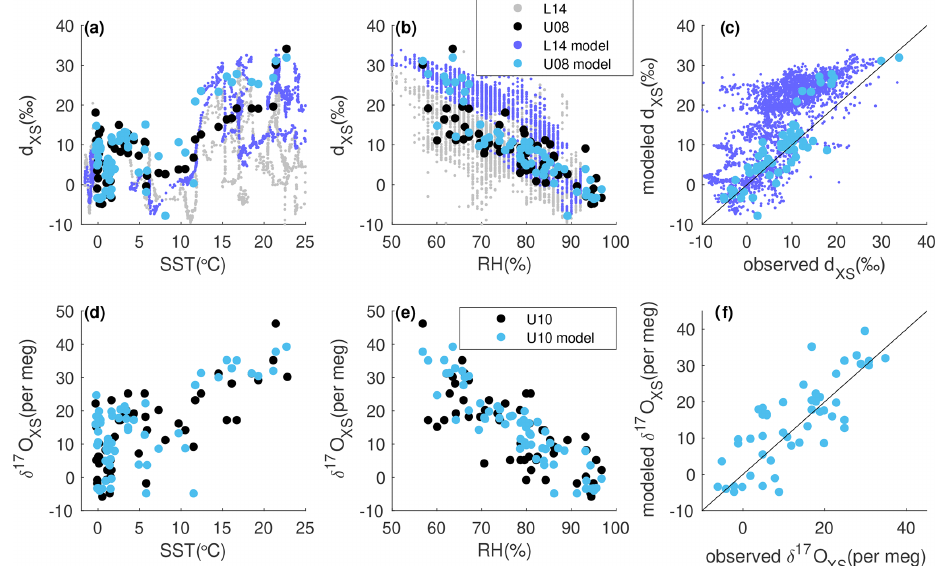
Figure A4. Comparison of modeled and observed isotope excess parameters and relationship to source region conditions. (a) Observed d xs and SST relationship in Southern Ocean vapor from Uemura et al. (2008) (black dots, U08) and Liu et al. (2014) (grey dots, L14). SWIM results for evaporation under SST and RH conditions observed coincident with vapor measurements of Uemura et al. (2008) (cyan dots, U08 model) and Liu et al. (2014) (purple dots, L14 model). (b) Same as (a) but for modeled and observed d xs -to-RH relationship from observations of Uemura et al. (2008) The Liu et al. (2014) observations and model show a similar trend and are omitted for visual clarity. (c) Observed 17 O xs and SST relationship in Southern Ocean vapor from Uemura et al. (2010) (black dots, U10) and SWIM results run under observed sea surface conditions (cyan dots, U10 model). (d) Same as (c) but for observed and modeled 17 O xs and RH relationship in Southern Ocean